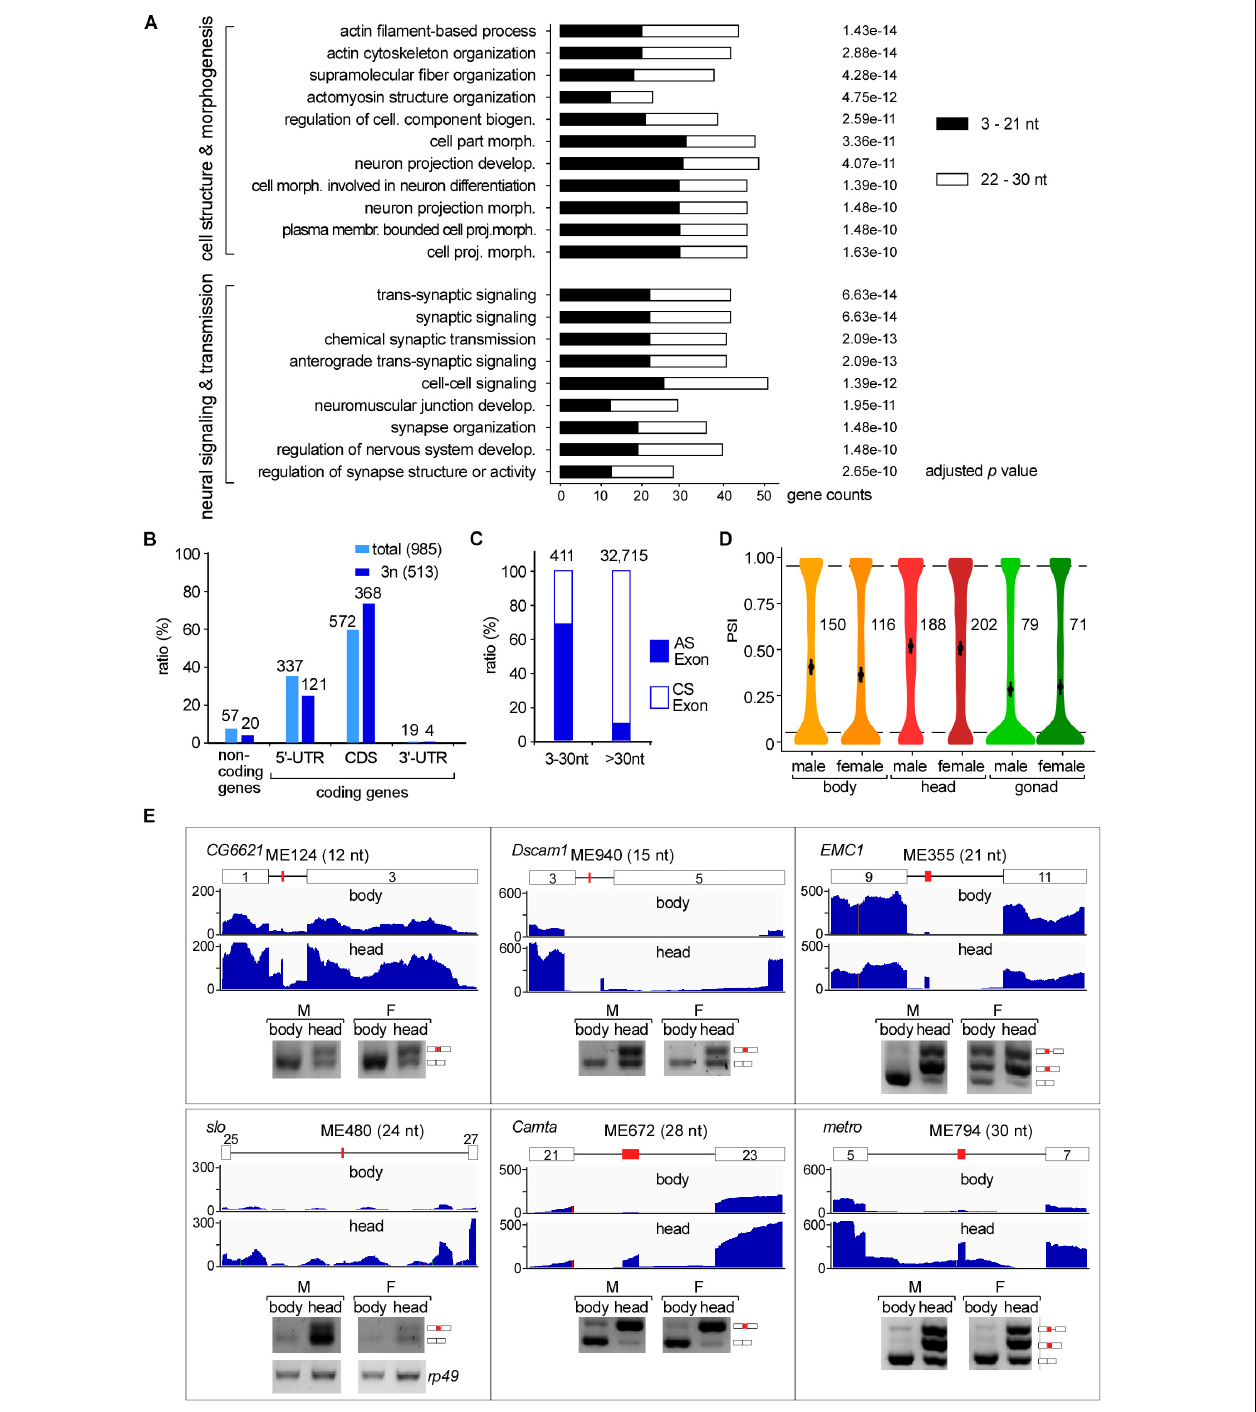
FIGURE 3 | Tissues specific AS of Drosophila microexons. (A) Microexon-containing genes in Drosophila are highly enriched in two aspects of cellular functions by GO analysis. Enriched microexons are also divided into two groups based on length. (B) Distribution of microexons in gene regions. 3n: microexons in the length of integer multiples of 3. (C) Ratio of the AS exons is much higher in microexons than in longer exons. Microexons and longer exons that are located in the CDS region and have flanking exons were retrieved and analyzed. AS and CS exons were determined by transcriptomic information. (D) Distribution of the PSI values of AS microexons in Drosophila part/tissues. Average PSIs are indicated for each sample. (E) Validation of head-specific AS microexons by RT-PCR. Each microexon was validated by amplification of cDNA using two primers located in its flanking exons. Lengths, belonging genes, and names of microexons are indicated. Blank boxes: flanking exons, orange boxes: microexons. Primers information is listed in Supplementary Table 1